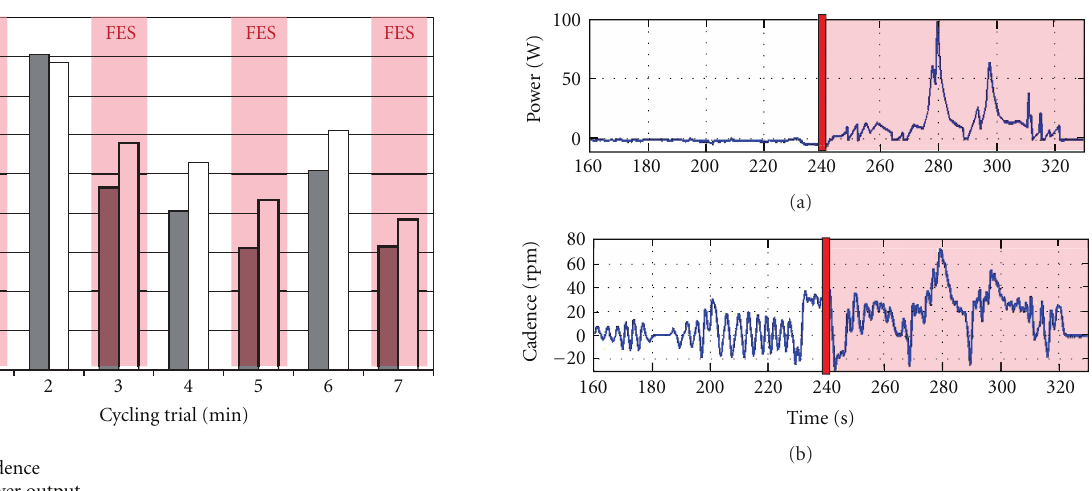
Figure 5: Cycling performance during the initial application of FES in a child for whom cycling was a novel task (participant 2). The top trace (a) illustrates his power output and the bottom trace (b) illustrates his cadence. The red vertical bars at 240 s indicate when FES assistance began and FES remained on during the red- shaded portion of the graph. Data were smoothed for analysis using a second-order lowpass Butterworth filter with a cuto ff frequency of